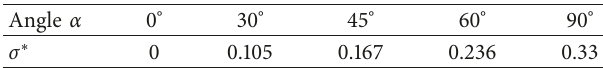
Table 2: The theoretical initial stress triaxialities of different specimens.